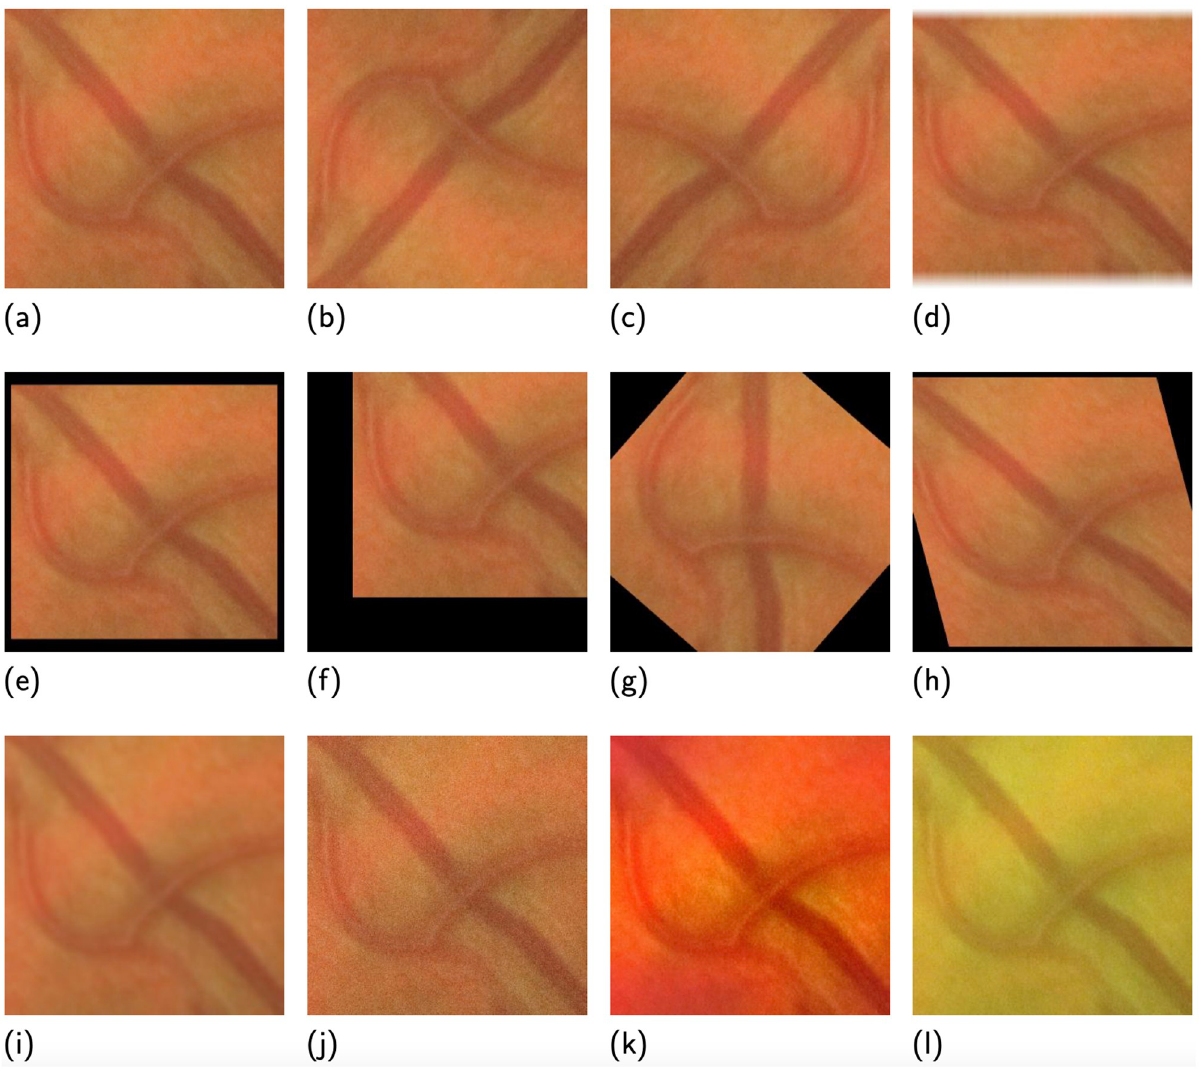
Fig 4. Our data augmentation operator pool. (a) Raw image, (b) vertical flipping, (c) horizontal flipping, (d) cropping and padding, (e) scaling, (f) translating, (g) rotating, (h) sheering, (i) blurring, (j) additional noise, (k) additional frequency noise, and (l) color modification.